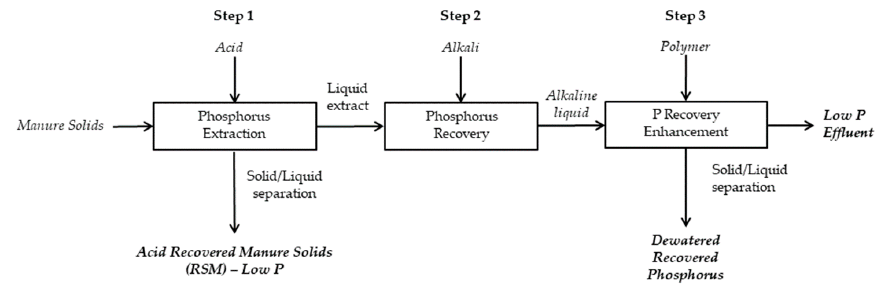
Figure 1. Quick Wash process schematic for phosphorus (P) extraction and recovery.